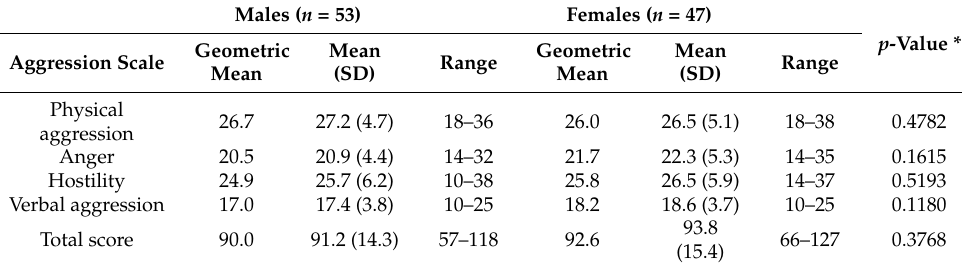
Table 3. Geometric mean, median and range of aggression scores by sex.